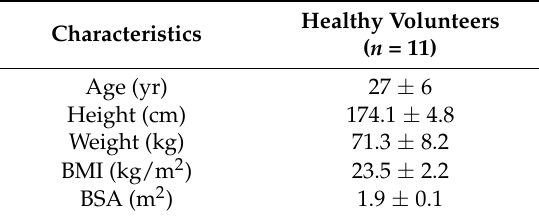
Table 2. Characteristics of healthy